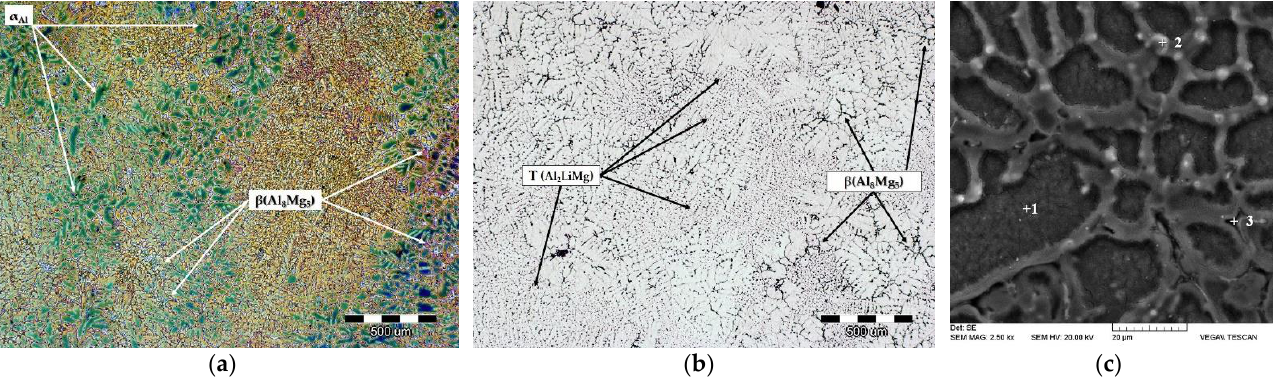
Figure 6. The microstructure of the sample in as-cast condition: ( a ) etched with Weck’s etching solution; ( b ) etched with Keller’s etching solution; ( c ) SEI with indicated details for EDS analysis. Table 4. The results of the EDS analysis of the as-cast sample performed on the details indicated in Figure 6c.